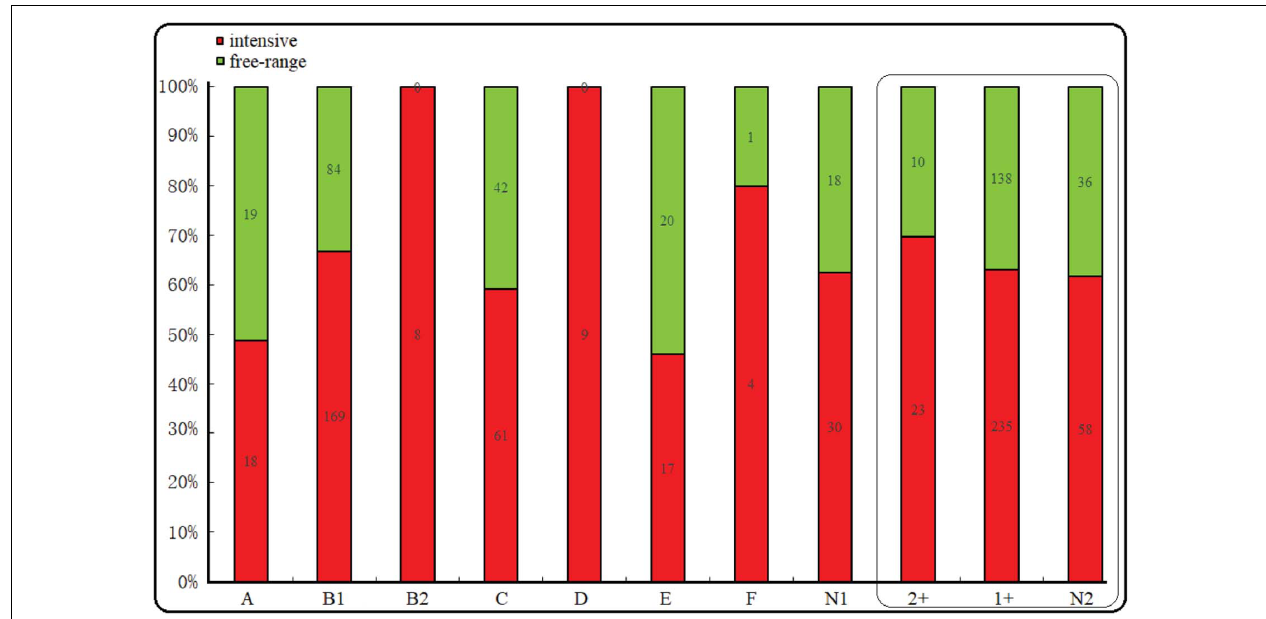
FIGURE 2 | Phylogenetic and biofilm formation in the wool sheep E. c oli from two different farming systems (n = 500). The box inside represented the result of the biofilm formation. N1 indicated unclassified phylogroups. Based on the OD the strain’s biofilm formation was determined as: no biofilm formation N2, weak (1+) and moderate (2+) biofilm formation. Red and green colors indicated intensive and free-range, respectively.